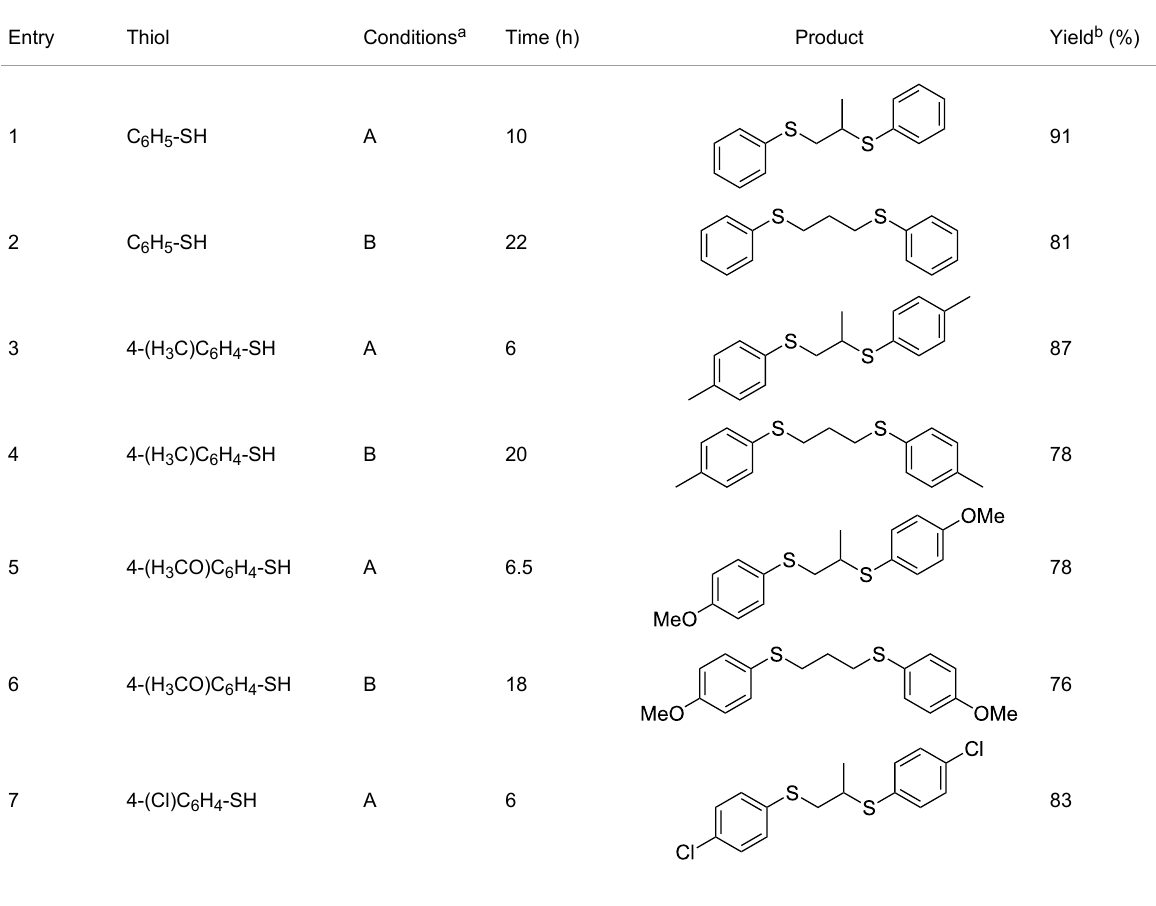
Table 2: Regioselective one-pot synthesis of 1,2 and 1,3-dithioethers using dry (pre-calcined) or moistened silica gel at room